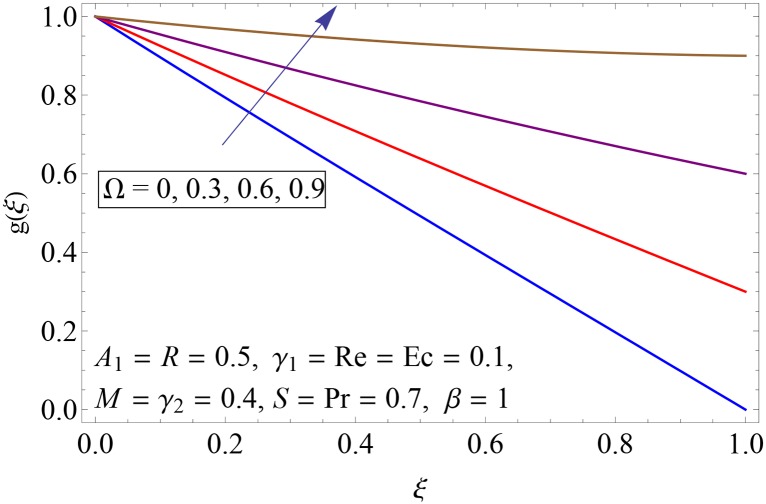
Impact of Ω on g(ξ).